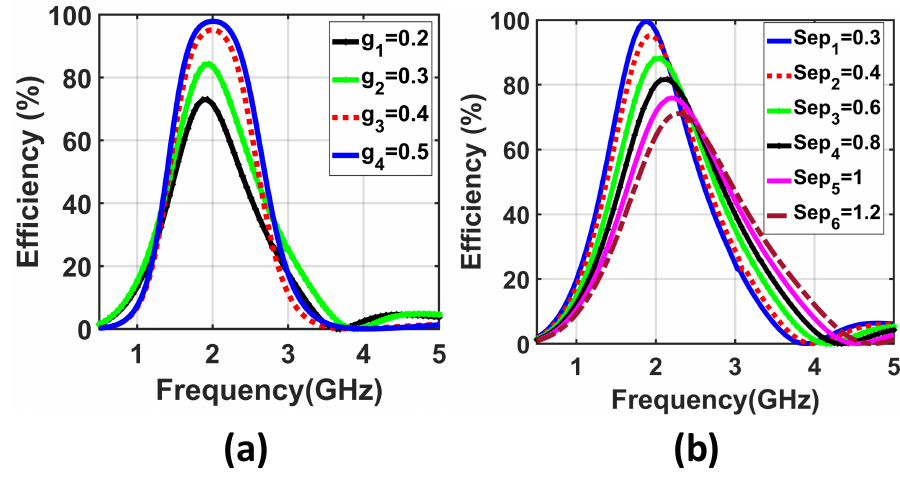
Figure 4. Numerical results of the presented dual polarized planar 2 × 2 supercell demonstrating, ( a ) the efficiency with varied gaps from g 1 = 0.2 mm to g 4 = 0.5 mm and ( b ) the efficiency with various lateral separation distance between adjacent cells.